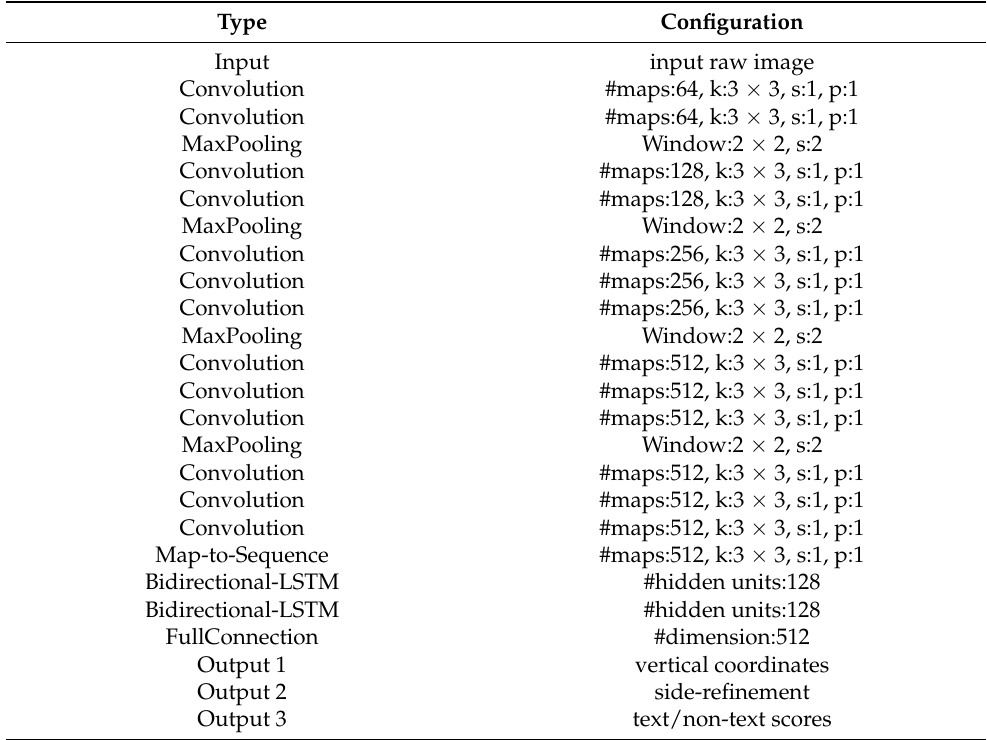
Table A1. Network configuration summary of CTPN. ‘k’, ‘s’, and ‘p’ stand for the kernel size, stride size, and padding size, respectively.